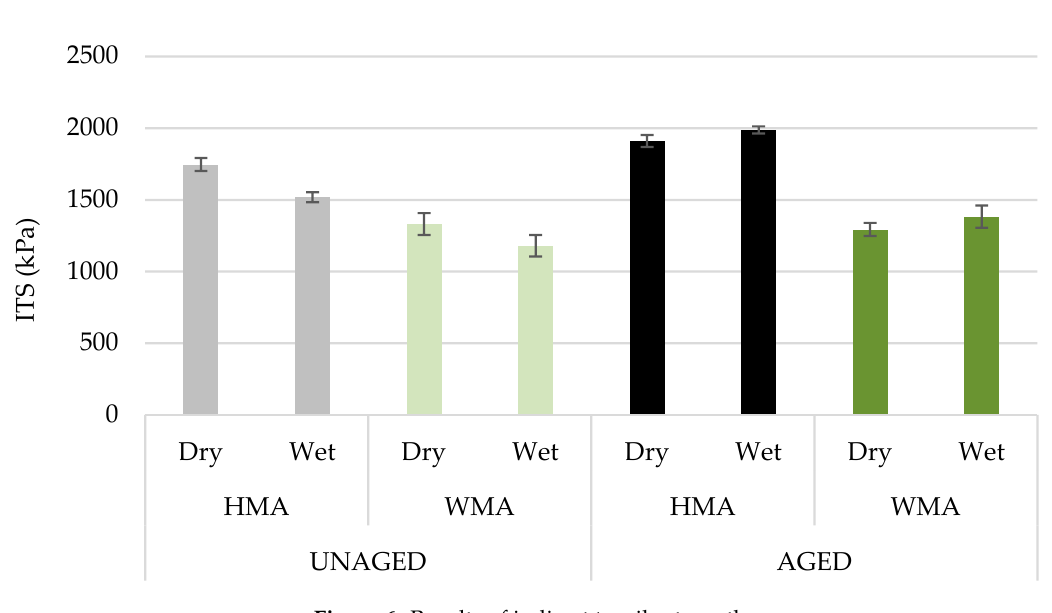
Figure 7. Results of indirect tensile strength ratio (ITSR) values.